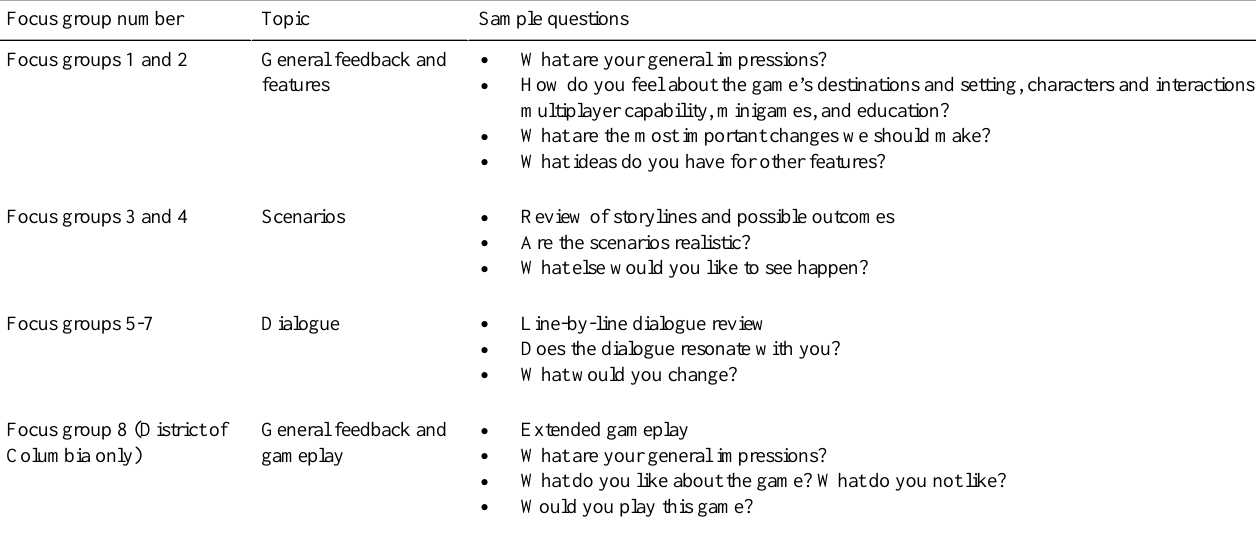
Table 1. Overview of focus group discussion topics.